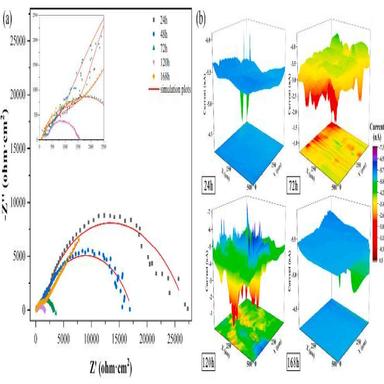
(a) Nyquist plots and (b) SECM mappings of the ST sample during immersion in SBF.